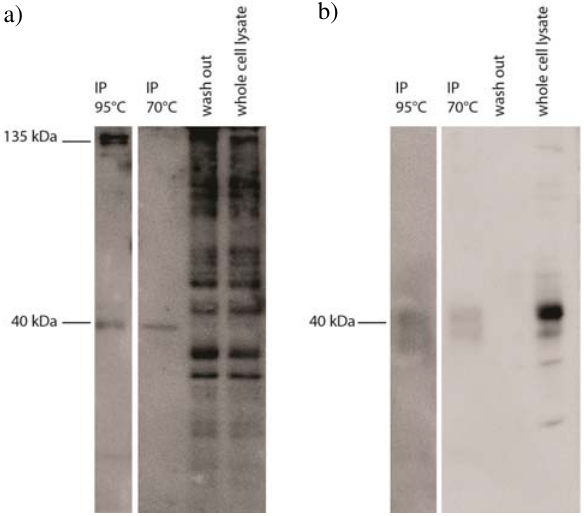
Figure 3. Co-immunoprecipitation with FLAG Ab conjugated Sepharose of Car-Flag and Per2-V5 . A : Western blot with V5 Ab – PER2 shows two bands, at 40 and 135 kDa. After the final incu- bation of Sepharose beads at 70 °C, only the 40 kDa form was vi- sible on the blot. The 135 kDa isoform was visible after additional incubation at 95 °C. B : Western blot with FLAG Ab – the signal of CAR is in the range of expected protein size (40 kDa).